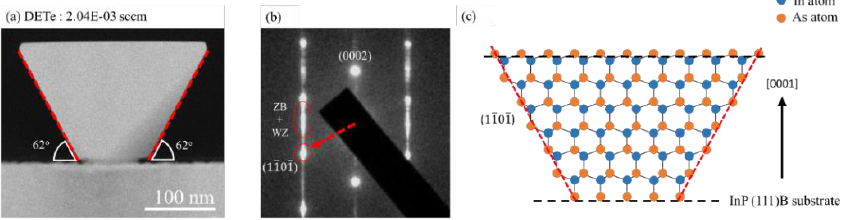
Figure 5. ( a ) Cross-sectional STEM image showing Te-doped InAs NWs. ( b ) SAED image of Te- doped InAs NWs on [ 112̅0 ] zone axis. ( c ) Projection of the Wurtzite type [ 112̅0 ] zone axis. InAs NWs on [1120] zone axis. ( c ) Projection of the Wurtzite type [1120] zone